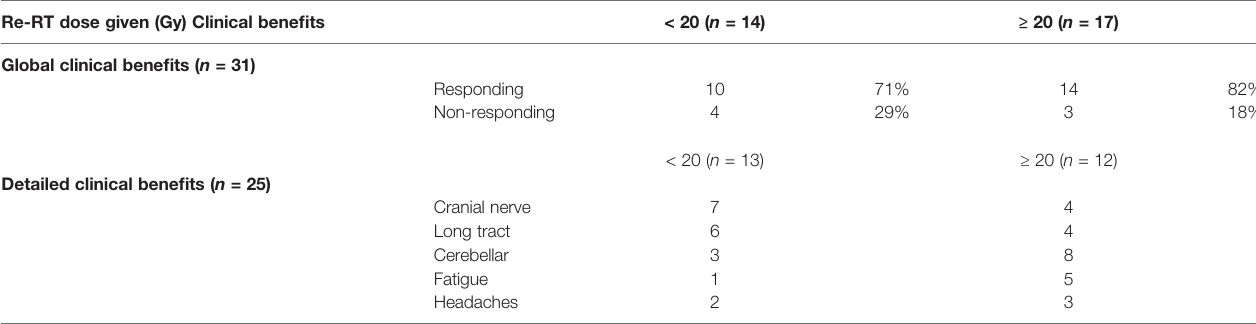
A difference appears to exist (23% versus 67%, chi-square p-value = 0.028) in improvement of cerebellar signs between the two groups (<20 Gy versus ≥ 20